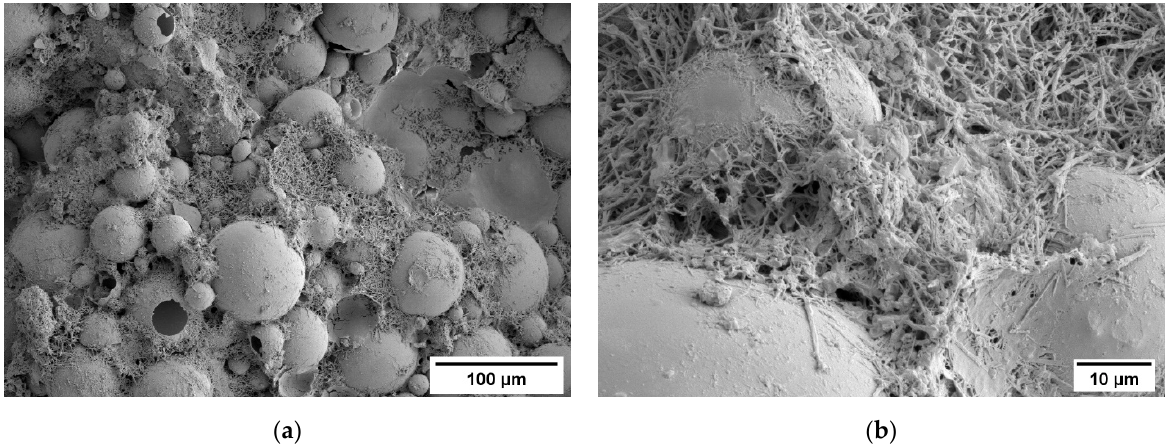
Figure 5. SEM images of sample 50C, stored for 14 days in a moist atmosphere. The acceleration voltage was set to 5 kV, using a SE detector: ( a ) magnification 250×; ( b ) magnification 1500×. The needle-like structures surrounding the HGMSs are characteristic for